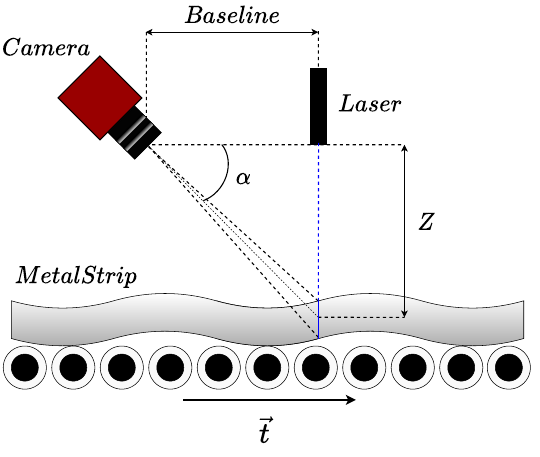
Figure 1. The flatness sensor scheme used for data acquisition, consisting of a single laser line laser triangulation